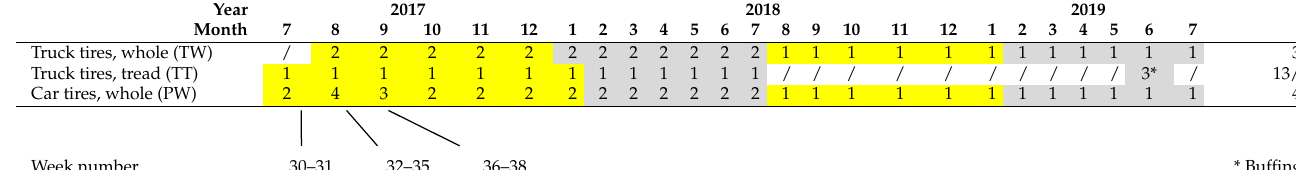
Table 2. Measurement frequency of the different materials.